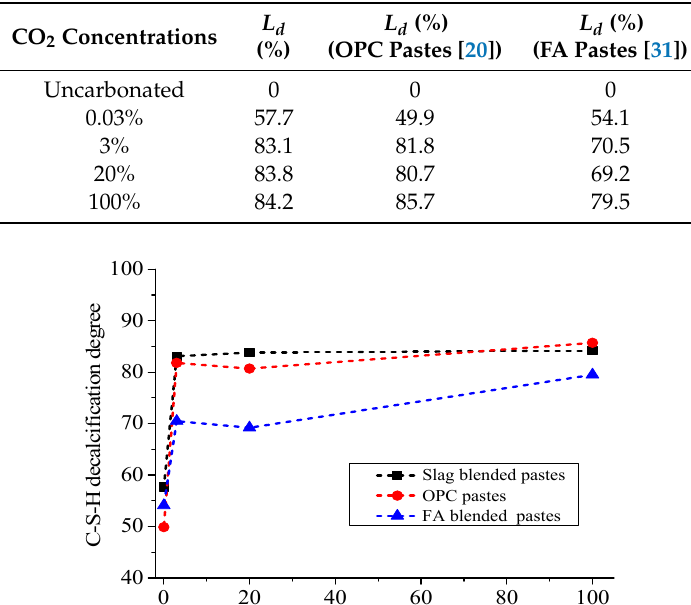
Table 4. Degree decalcification of C-S-H ( L d ) calculated from Equation (1).